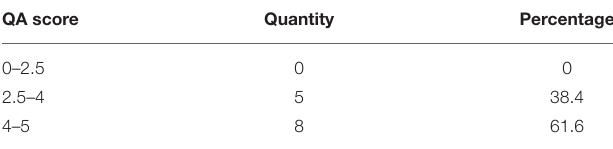
TABLE 2 | Quality assessment—statistics.